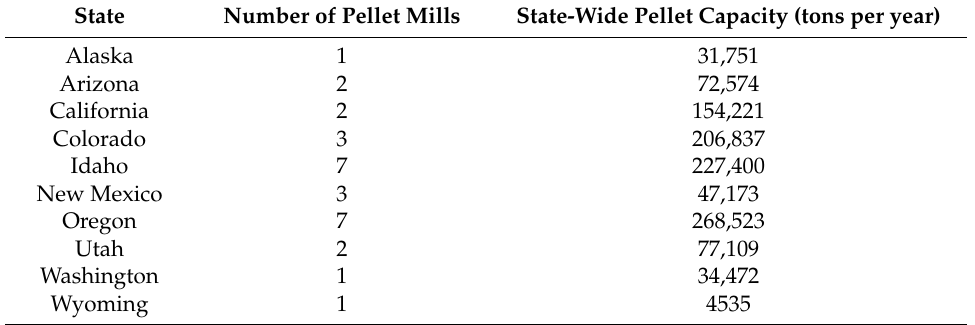
Table 3. Pellet mills and capacity, by state, for the western